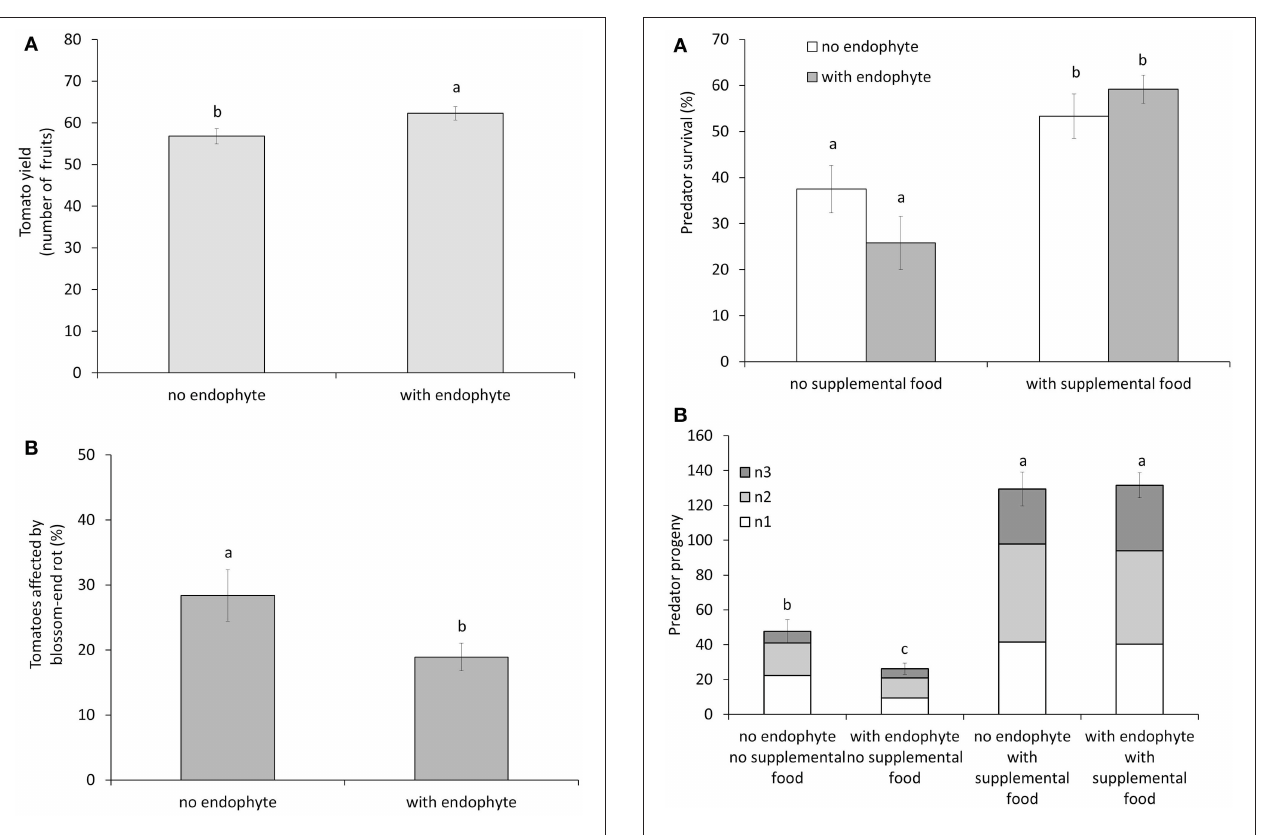
FIGURE 2 | Total number ( ± SE) of fruits (A) and the percentage ( ± SE) of these fruits with blossom-end rot (B) from tomato plants without or with inoculation of the endophyte Fo162. Different letters above bars indicate significant differences between treatments (ANOVA, p < 0.05). endophyte [ F (1,16) = 0.3, p = 0.593], nor was the interaction